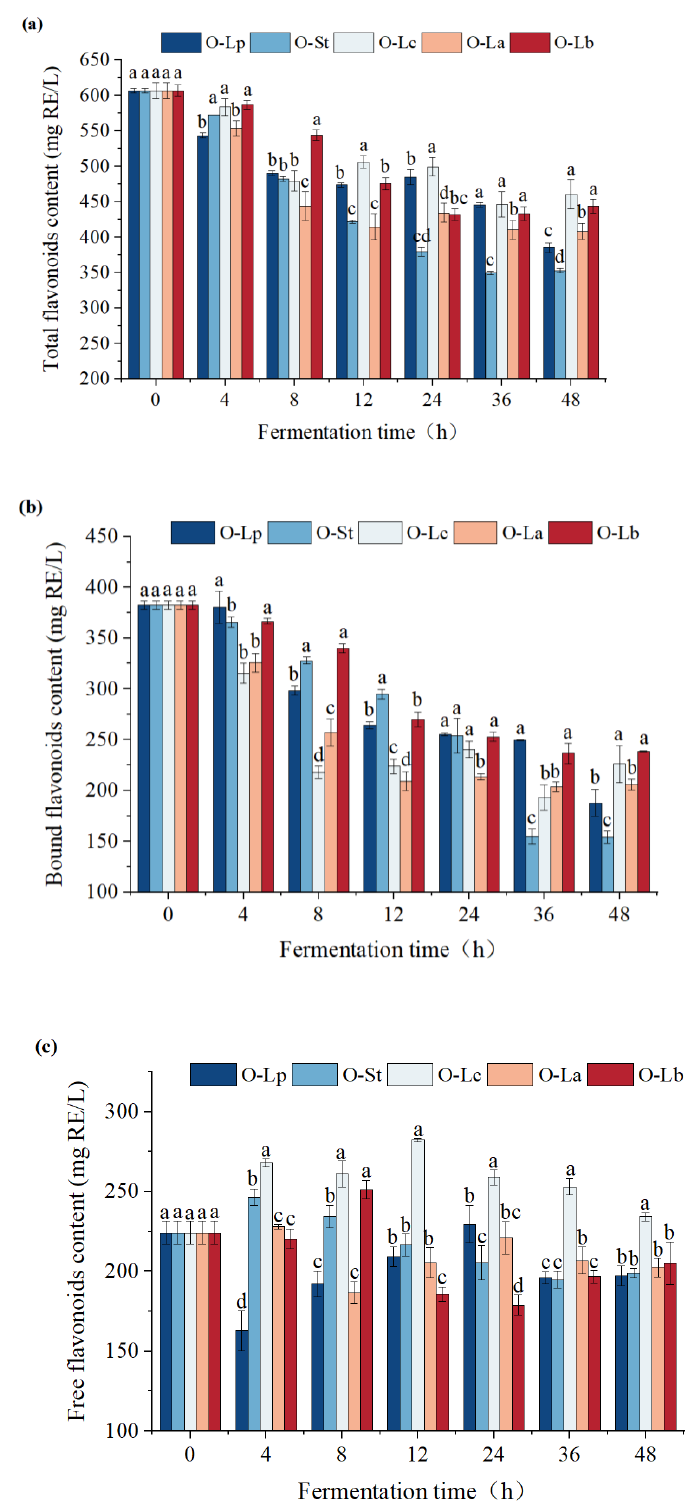
Figure 4. Contents of total flavonoids ( a ), bound flavonoids ( b ) and free flavonoids ( c ) in samples of different strains at different fermentation time. Different letters indicate significant differences among different strains a given fermentation time ( p < 0.05). O-Lp, sample fermented with L. plantarum ; O-La, sample fermented with L. acidophilus ; O-Lc, sample fermented with L. casei ; O-Lb, sample fermented with L. bulgaricus ; O-St, sample fermented with S. thermophilus . H,